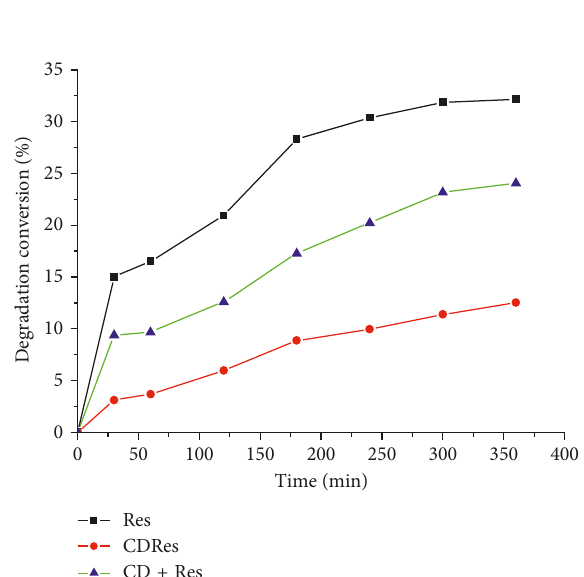
Figure 6: Difference in degradation conversion versus length of time of irradiation of 360 min for 50% of the methanol solution